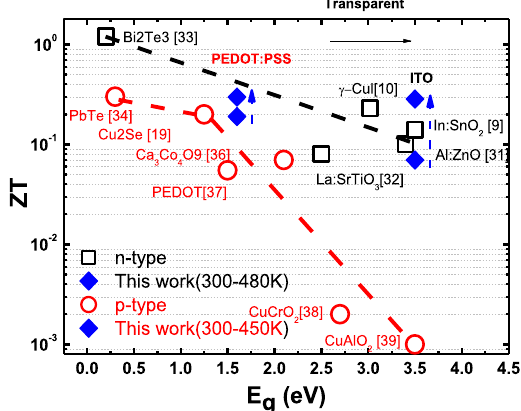
Fig. 5 Figure-of-merit zT of reported n - and p -type thermoelectric materials at room temperature versus energy bandgap, compared with this work. Notably, the zT values of n -type ITO and p -type PEDOT:PSS thin fi lm in this work are adjusted to a similar level to achieve a high-performance fl exible TE module with high transparency.